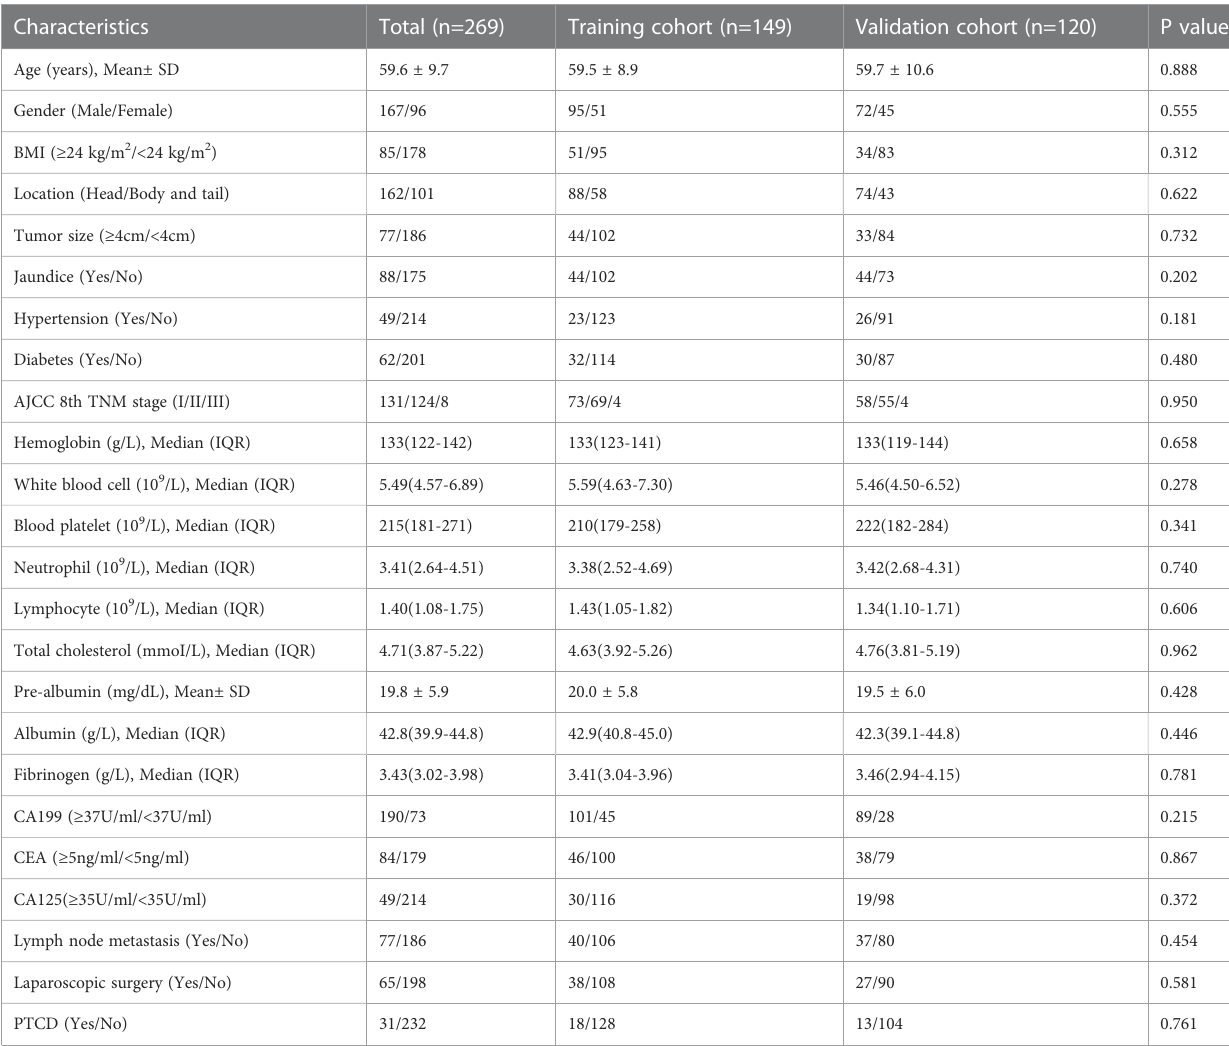
TABLE 1 Baseline characteristics of enrolled patients.